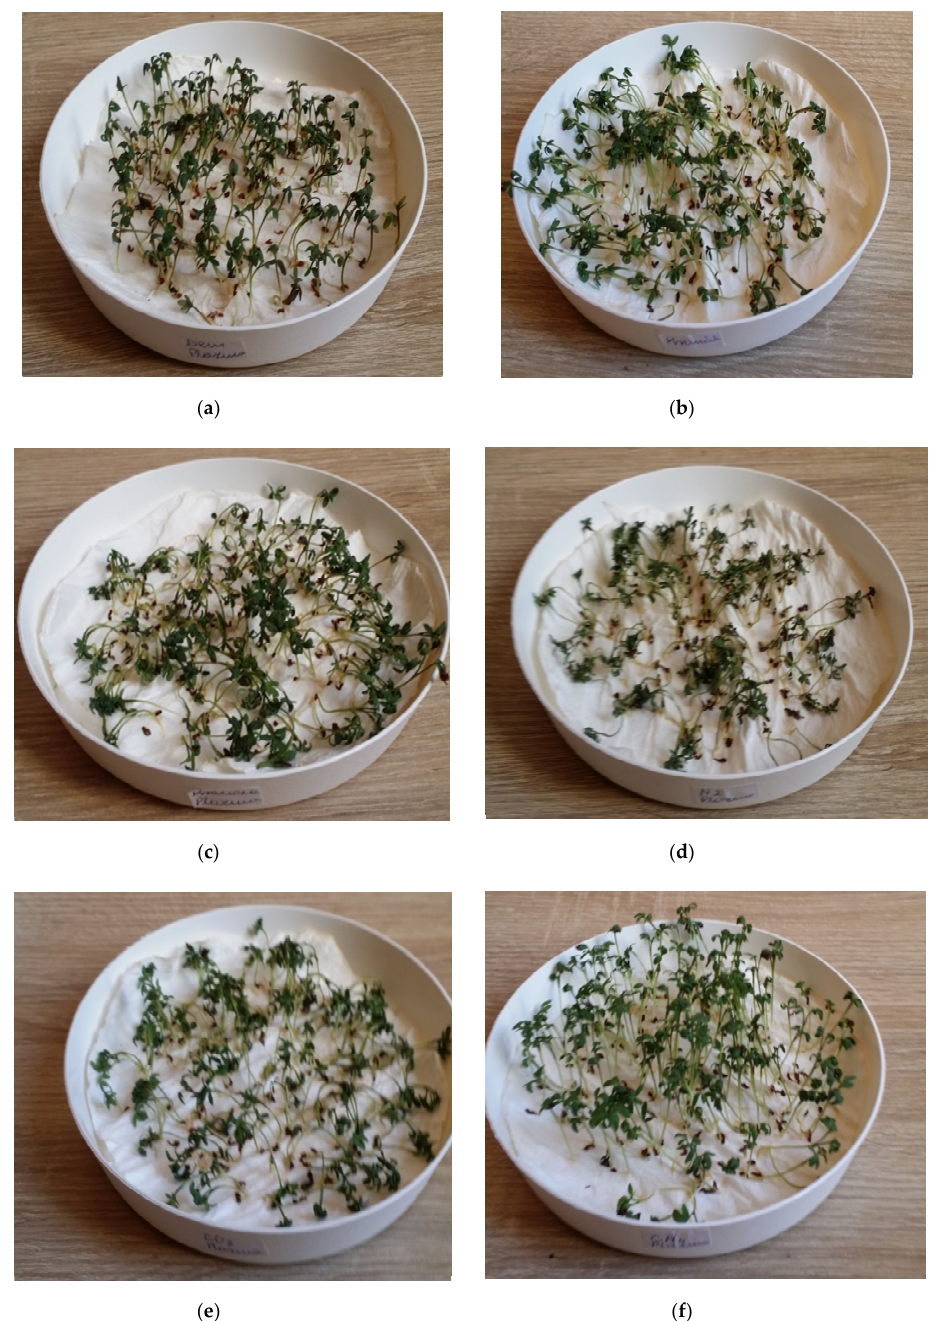
Figure 1. Condition of the planted cress watered with deionized LPGPA-treated water ( a ), tap non-treated water ( b ), tap LPGPA-treated water ( c ), tap LPGPN-treated water ( d ), tap LPGPC-treated water ( e ) and tap LPGPM-treated water ( f ). The photographs were taken on the 7th day of the experiment.